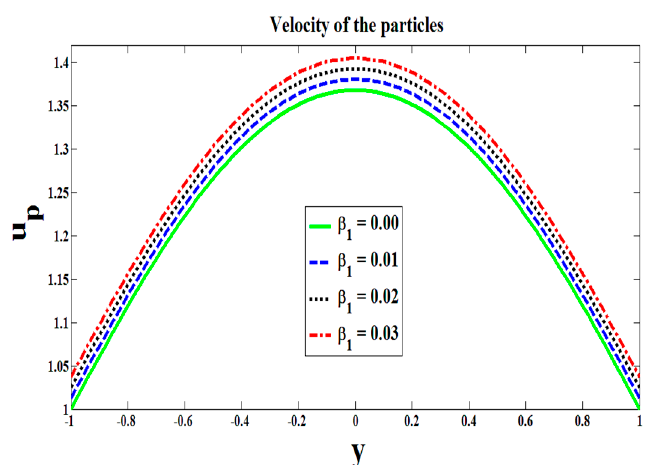
Figure 9. Effects of slip parameter on the motion of particles.